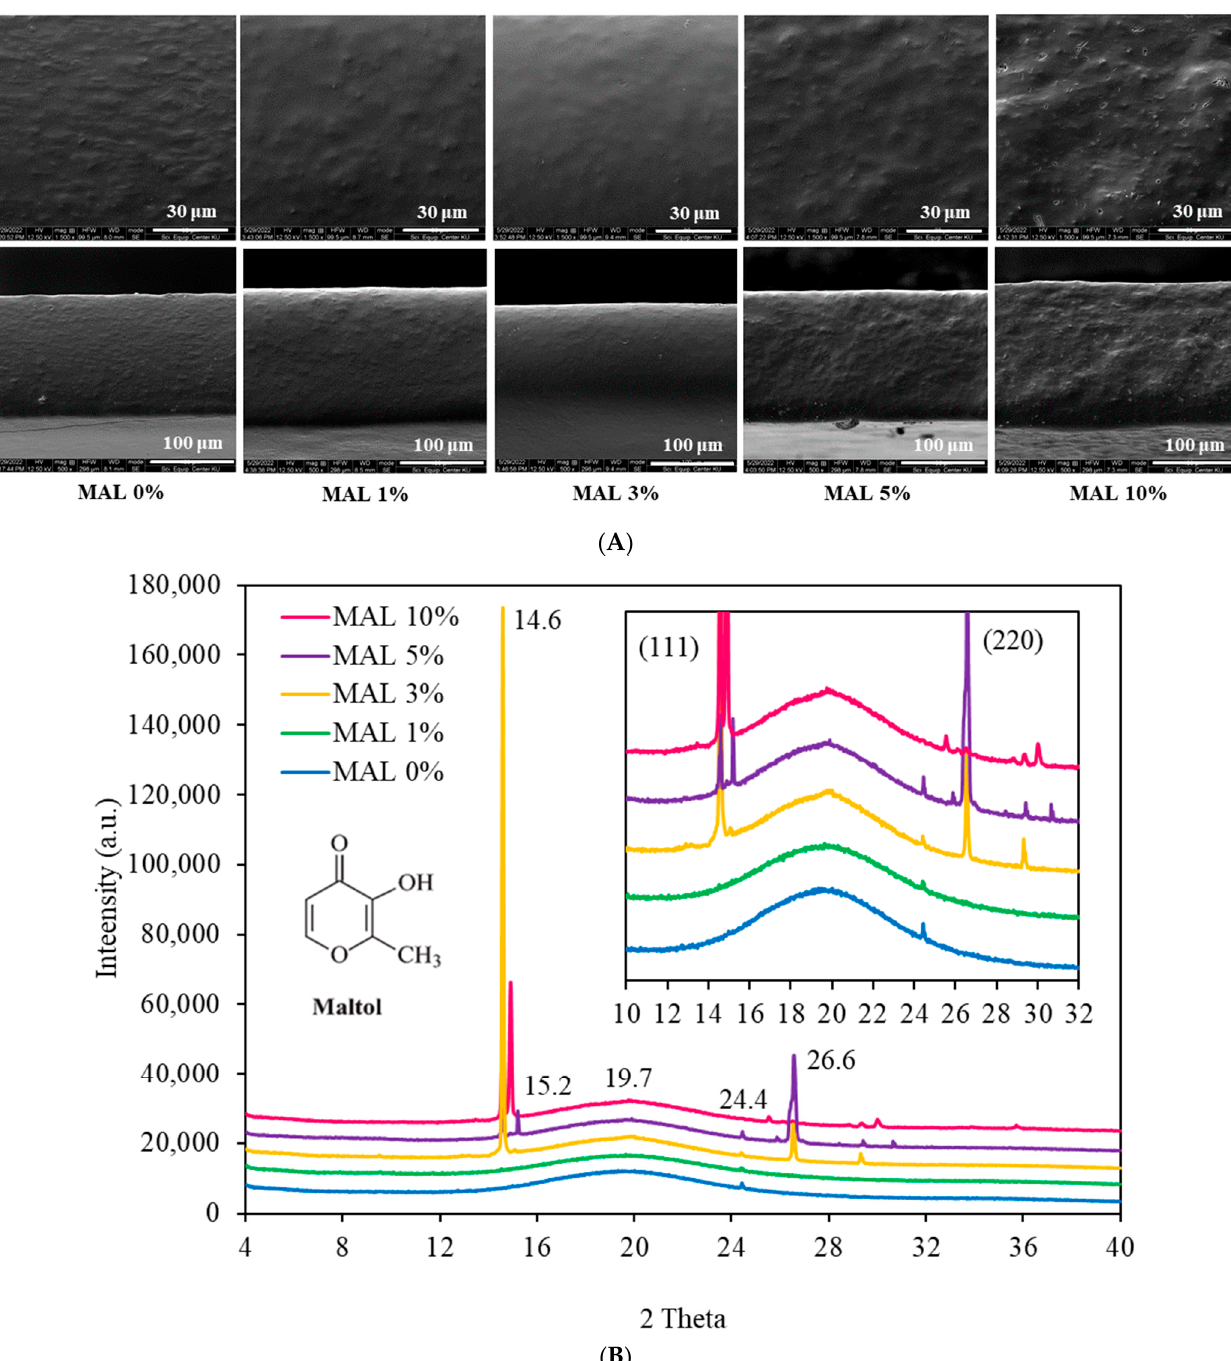
Figure 1. ( A ) Microstructures on surface ( upper row ) and cross-section ( lower row ) and ( B ) X-ray diffractogram of starch films containing maltol (MAL) at 0, 1, 3, 5 and